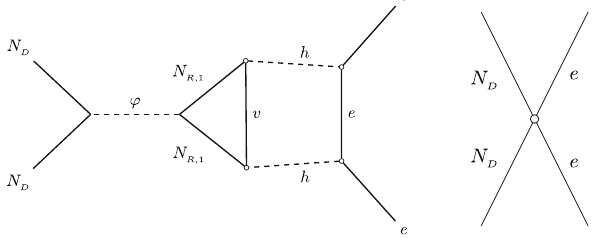
σ (cid:2) 10 − 47 cm 2 , for the low DM mass, m